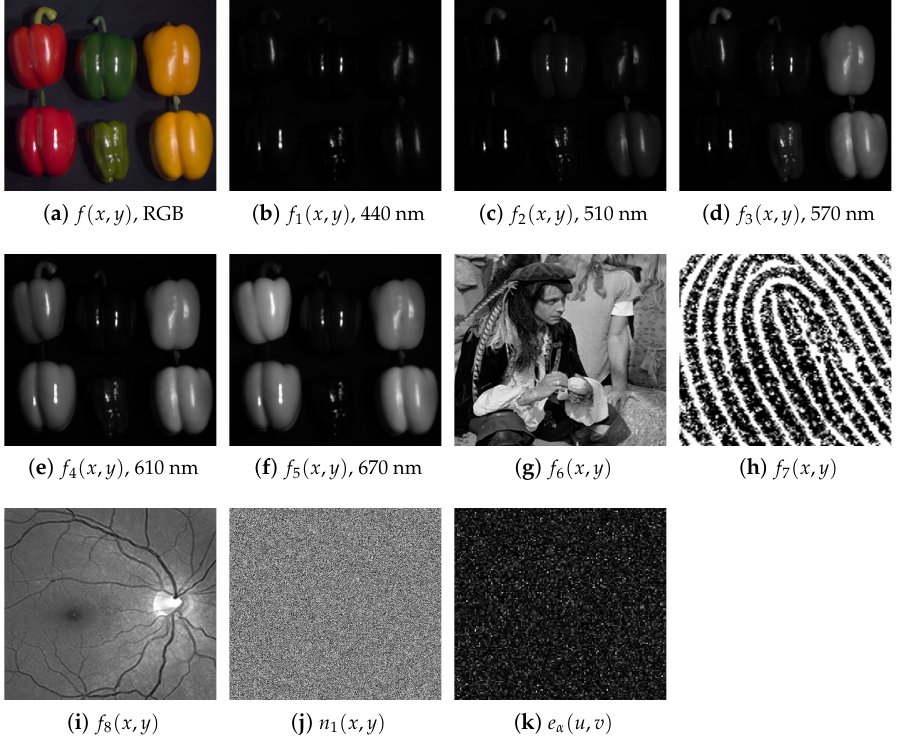
Figure 3. ( a ) Original image f ( x , y ) in the RGB color space. Multispectral image to encrypt corre- sponding to f ( x , y ) with five different color (wavelength, λ ) channels: ( b ) f 1 ( x , y ) at λ = 440 nm, ( c ) f 2 ( x , y ) at λ = 510 nm, ( d ) f 3 ( x , y ) at λ = 570 nm, ( e ) f 4 ( x , y ) at λ = 610 nm and ( f ) f 5 ( x , y ) at λ = 670 nm. Color image f ( x , y ) and its multispectral components were obtained from [48]. The remaining original grayscale images to encrypt: ( g ) f 6 ( x , y ) , ( h ) f 7 ( x , y ) and ( i ) f 8 ( x , y ) . ( j ) Image of the random distribution n 1 ( x , y ) of the RPM h 1 ( x , y ) . ( k ) Encrypted image e α ( u , v ) for the rotation angle α = 0.775 π